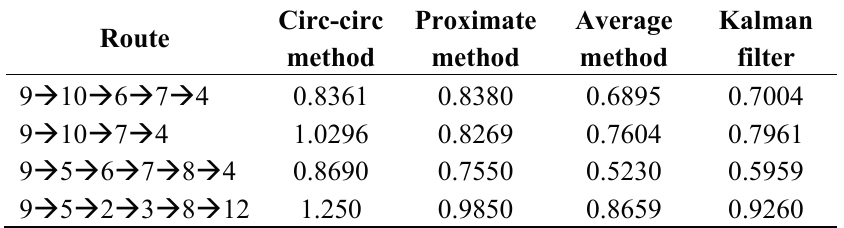
Table 4. Positioning mean errors with different position methods.